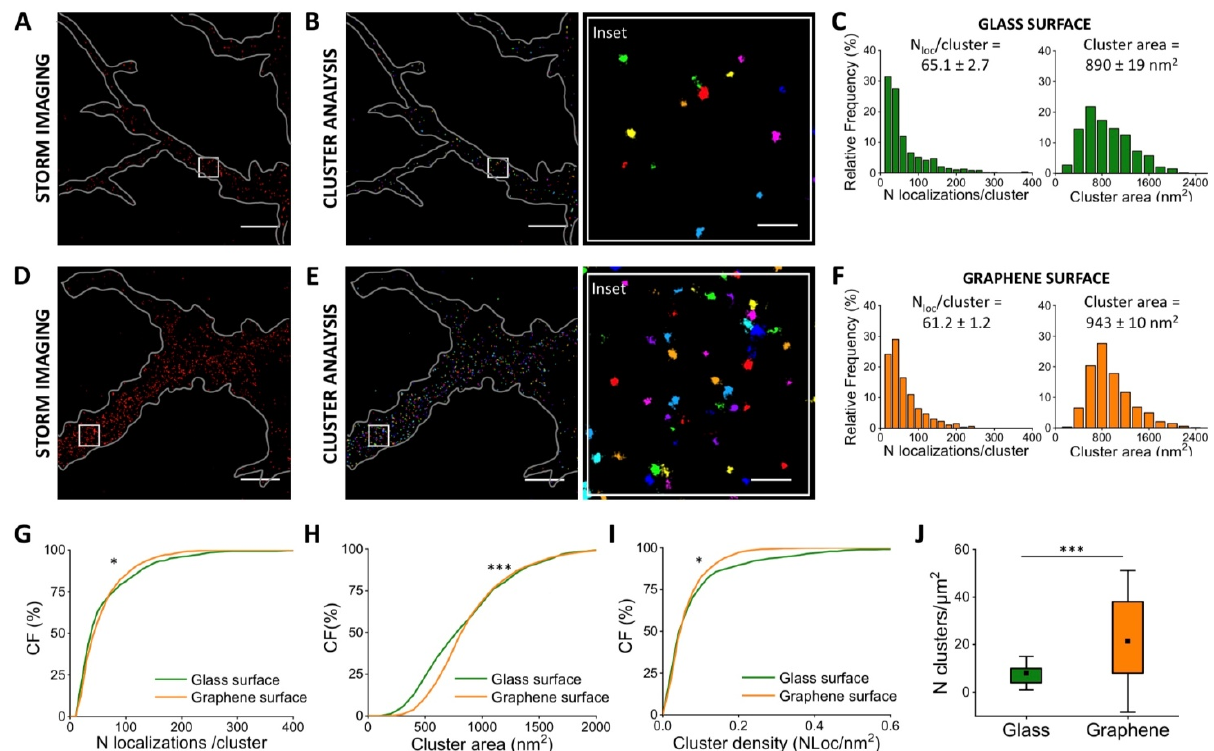
Figure 4. Quantitative super-resolution imaging of vinculin in neurons (DIV3). STORM imaging ( A ) and cluster analysis ( B ) of vinculin immuno-stained with A405/A647 in neurons seeded on glass. Frequency distribution of localizations/cluster and cluster area measured in cells seeded on glass ( C ). STORM imaging ( D ) and clustering ( E ) of vinculin immuno-stained with A405/A647 in neurons seeded on SLG. Frequency distribution of localizations and cluster area in cells grown on SLG ( F ). The cumulative distribution shows a 6% decrease in the average number of localized events ( G ) for vinculin in cells adhered on SLG (61.2 ± 1.2 N loc /cluster) compared to cells adhered on glass (65.1 ± 2.7 N loc /cluster). The cumulative distribution shows a 6% increase in the average cluster area ( H ) in cells adhered on SLG (943 ± 10 nm 2 ) compared to cells adhered on glass (890 ± 19 nm 2 ). The cumulative distribution shows a 23% decrease in average density ( I ) in cells adhered on SLG (0.072 ± 0.002 N loc /nm 2 ) compared to cells adhered on glass (0.093 ± 0.005 N loc /nm 2 ). The average number of vinculin clusters/area ( J ) increases in cells grown on graphene (21.0 ± 4 N cluster / µ m 2 ) compared to glass (8.0 ± 0.9 N cluster / µ m 2 ). The box shows 25/75th percentiles and the whiskers are the standard deviation, T-test statistically significant, p < 0.05. The total number of analyzed clusters is N glass = 486 and N graphene = 1275 for glass and graphene substrates, respectively, for n > 4 independent experiments. Kolmogorov–Smirnov Statistical test: ns nonsignificant, * p < 0.05, *** p < 0.001. Scale bar = 5 µ m. Scale bar inset = 500